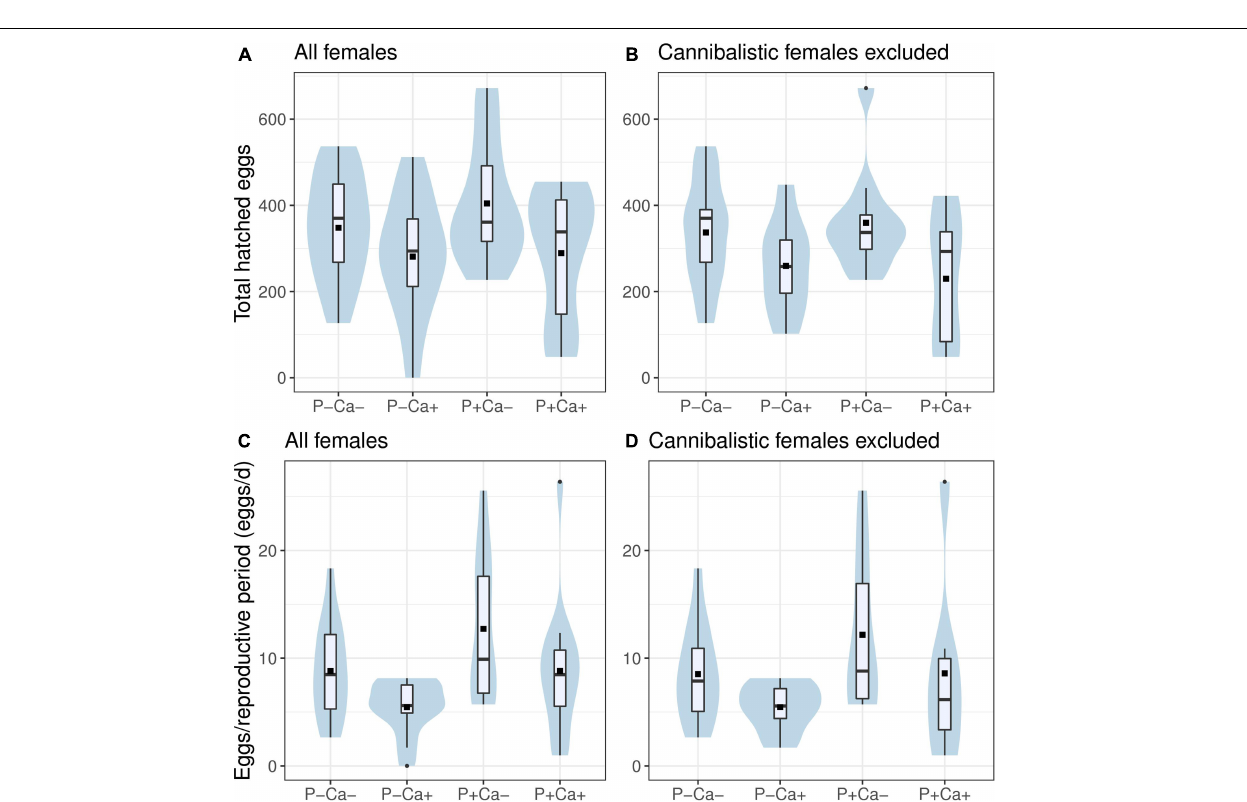
Frontiers in Ecology and Evolution |